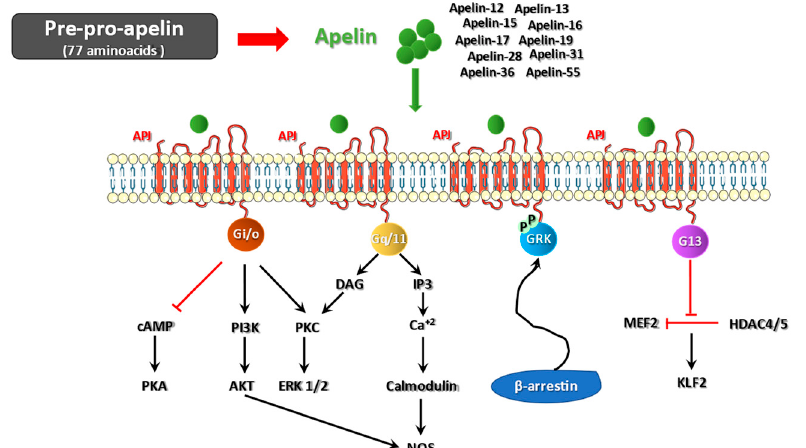
Figure 1. Intracellular pathways modulated by the apelin/APJ system. The 77-aminoacid precursor peptide, pre-pro-apelin, is cleaved in active fragments (apelin-12, apelin-13, apelin-15, apelin-16, apelin-17, apelin-19, apelin-28, apelin-31, apelin-36, apelin-55), which bind the apelin receptor APJ. By interacting with G proteins, apelin/APJ is able to modulate different signaling pathways: inhibition of cAMP generation and protein kinase A (PKA) and activation of phospho-inositide 3-kinase (PI3K)/AKT through Gi/o; activation of protein kinase C (PKC)-dependent extracellular signal-regulated kinase 1/2 (ERK1/2) through Gi/o or Gq/11; initiation of the intracellular release of Ca 2+ by Gq/11 and inositol 1,4,5-triphosphate (IP3) synthesis; autophosphorylation of APJ through G protein-coupled receptor kinase (GRK) and initiation of the β -arrestin-mediated internalization of the receptor; activation of G13 and inactivation of histone deacetylases (HDAC) type 4 and 5, determining the activation of myocyte enhancer factor-2 (MEF2) and expression of MEF2 target gene Kruppel-like factor 2 (KLF2). Both AKT activation and increase of intracellular Ca 2+ induces nitric oxide synthase (NOS).